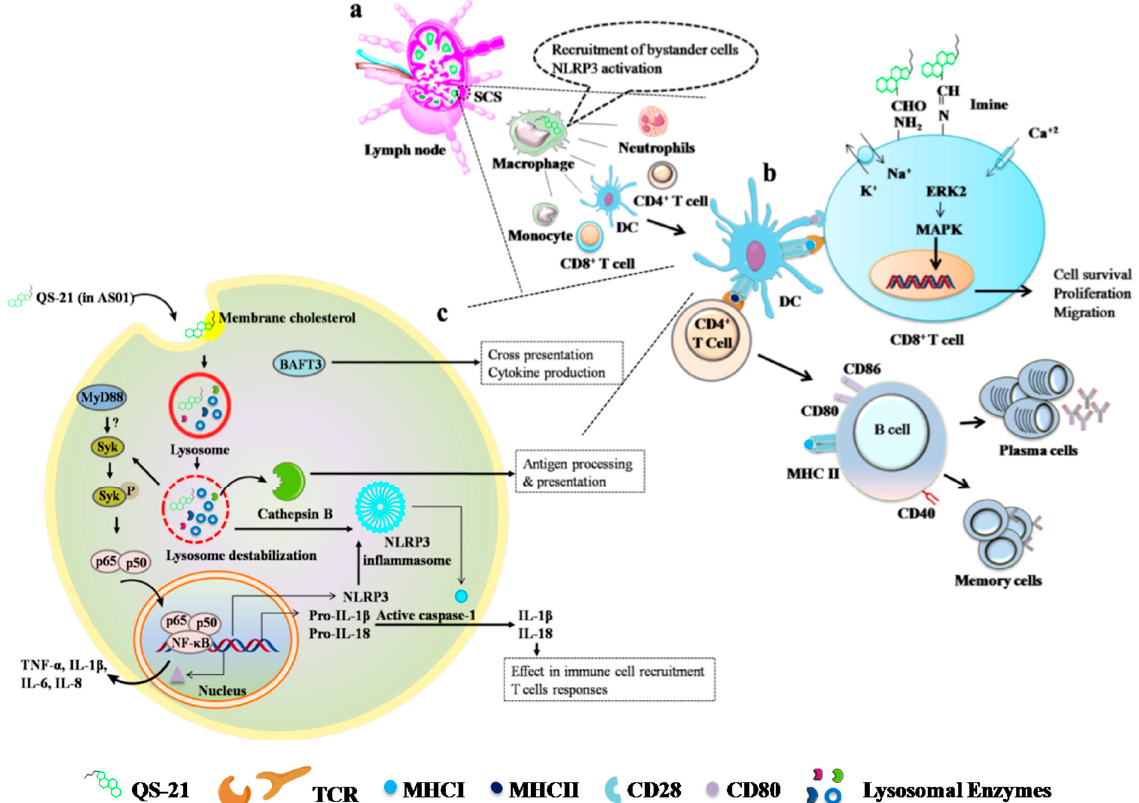
Figure 4. Proposed mechanisms of action of QS-21 in AS01 and QS-21 alone . a |Upon intramuscular injection, QS-21 (within the liposomes) drains to the lymph nodes and localizes at the subcapsular sinus (SCS) macrophages [240] . Macrophages activated via NLRP3 inflammasome pathways recruit other bystander cells including neutrophils, monocytes, and DCs [241]. b |QS-21 (within the liposomes) helps in the MHC-II and MHC-I antigen cross-presentation by forming a lipid body in the DCs and activating T cells [240,242]. Occasionally, in another way, QS-21 (alone) containing aldehyde moiety interacts with the T cell surface receptor ( ε -amino acid) (e.g., CD2) and induces costimulatory signals [211]. These interactions, followed by ion exchanges (K + , Na + , Ca 2+ ) and the activation of mitogen-activated protein (MAP) kinase, ERK2, and transcription factors, lead to cytokine release and cell proliferation, differentiation, and migration. c |QS-21 (within the liposomes) enters DCs via cholesterol-mediated endocytosis and situates itself in the lysosomes, where it destabilizes the lysosomes by forming size-specific pores. Cathepsin B (cysteine proteases) released from the lysosomes has an effective role in the immune functions mediated by QS-21. QS-21 (alone or in liposomes) activates the inflammasome (NLRP3), like other adjuvants, which induces active caspase 1 production. Activated caspase 1 coverts the pro-inflammatory cytokines (IL-1 β and IL-18) into active forms [240] .